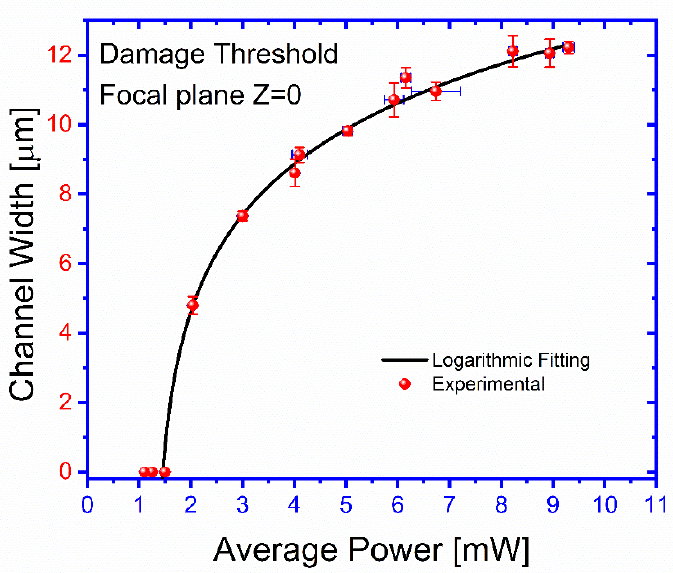
Figure 5. Laser micromachining channel width as a function of the beam average power for a beam focused on the ablated surface (Z = 0). The laser-induced damage threshold is about 2 mW. For a beam power smaller than this value, no ablation marking was observed.